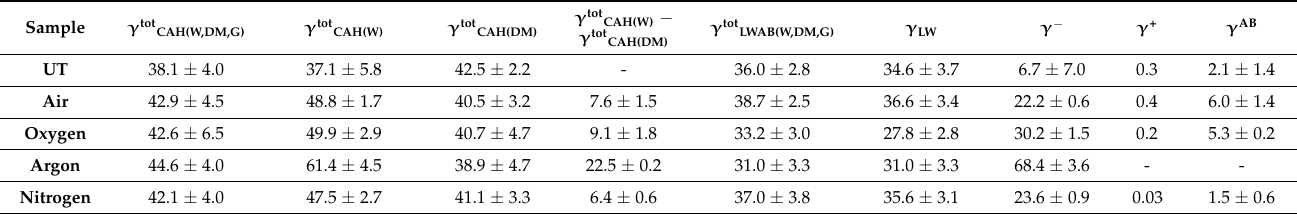
Table 1. Apparent surface free energy calculated from the CAH and LWAB